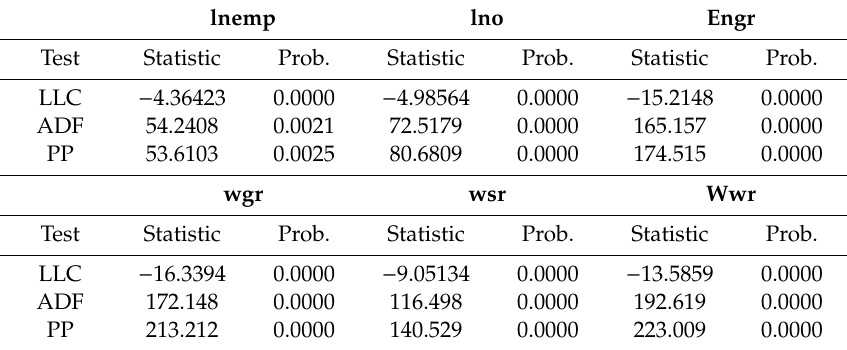
Table 7. Stationarity test of unit root of pollution industry panel.